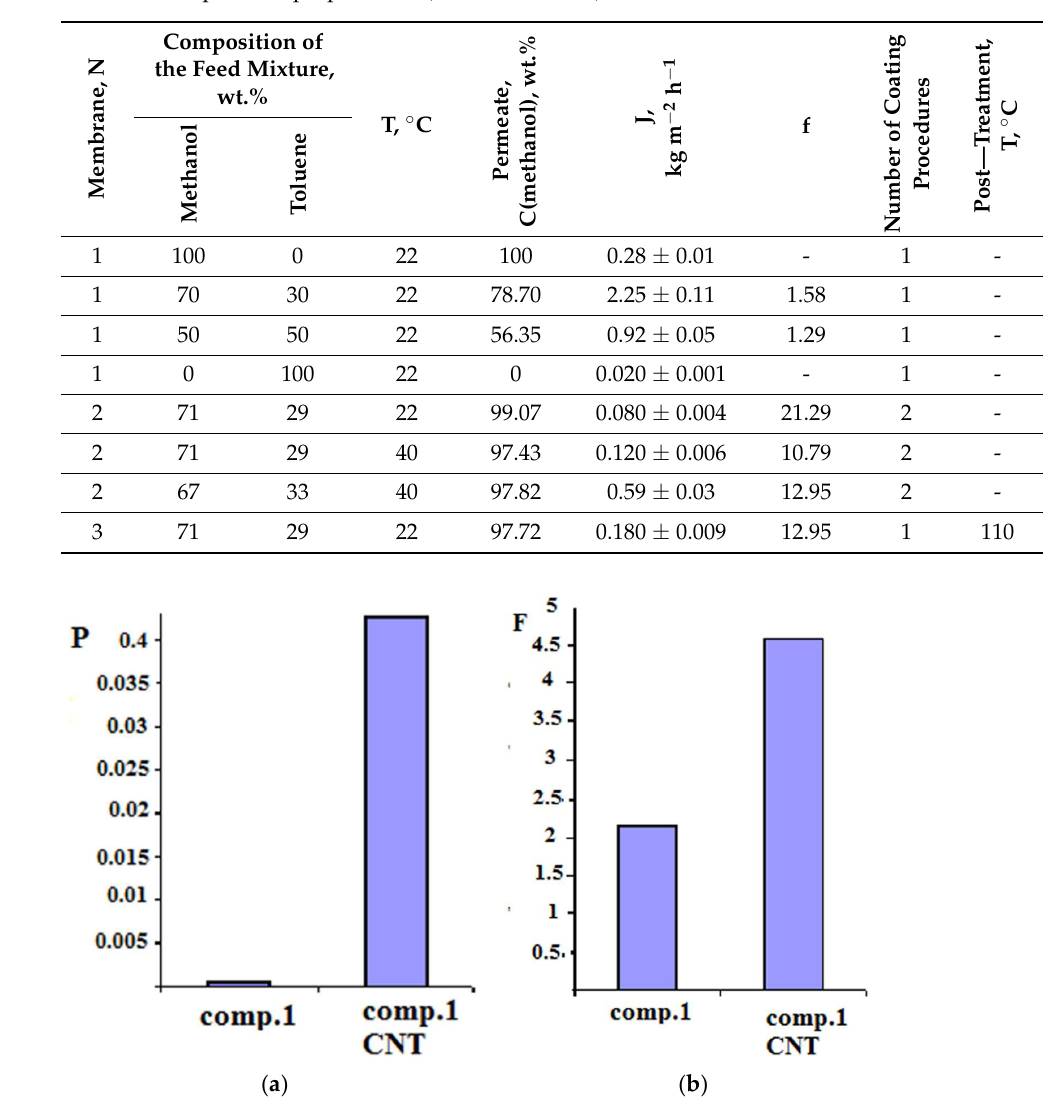
Table 3. Pervaporation properties of (PVA-PAA 80/20)/UPM-20 membranes.